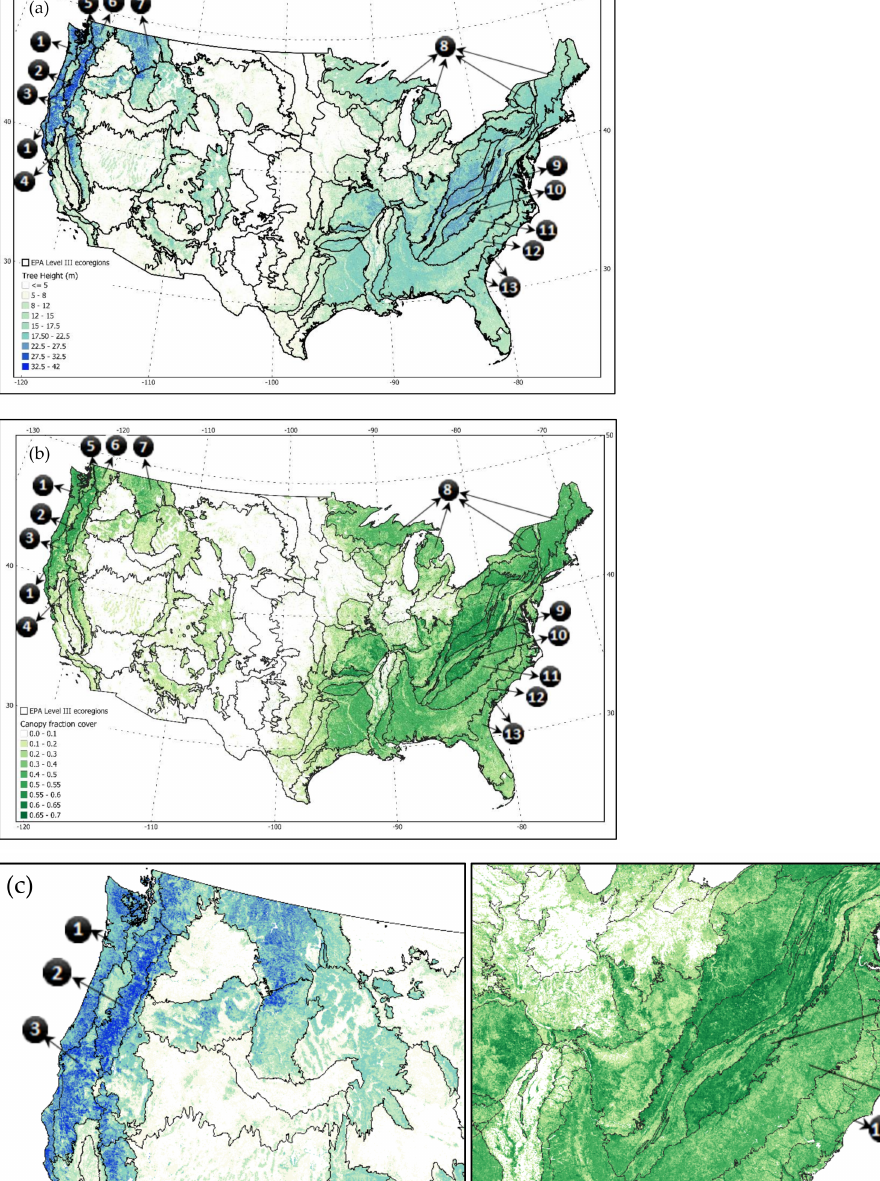
Figure 5. ( a ) Canopy height (CH) map (m) and ( b ) canopy fraction cover (CFC) maps for the conterminous US for the year 2019. Close-up examples illustrate ( c ) CH variations in the ecoregions of the Northwestern Forested Mountains, and ( d ) CFC variations between the Appalachians and the Piedmont Plateau. Key: Marine West Coast Forests,